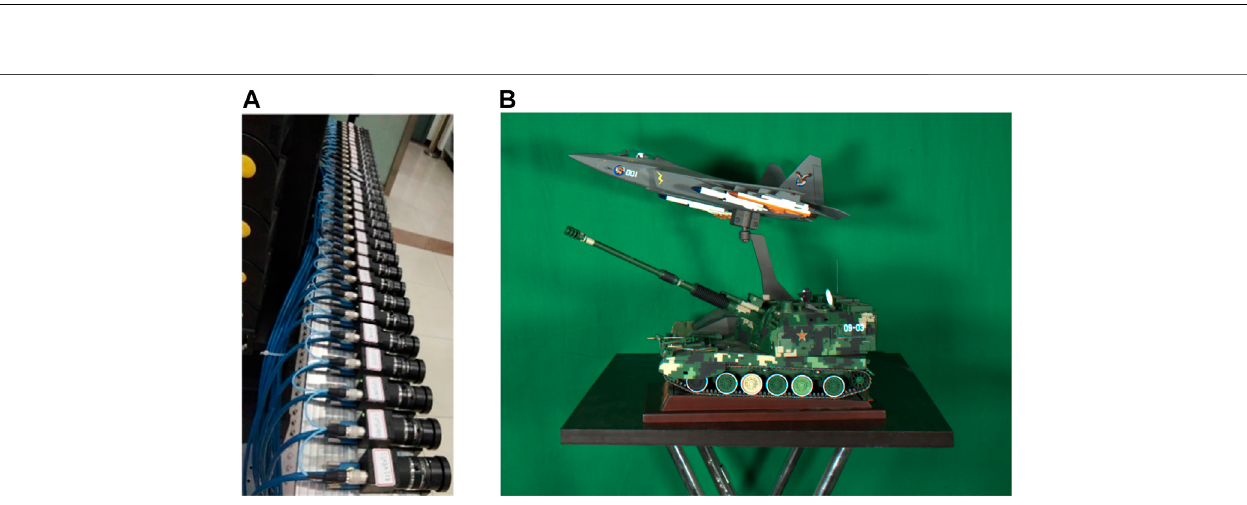
Frontiers in Physics |